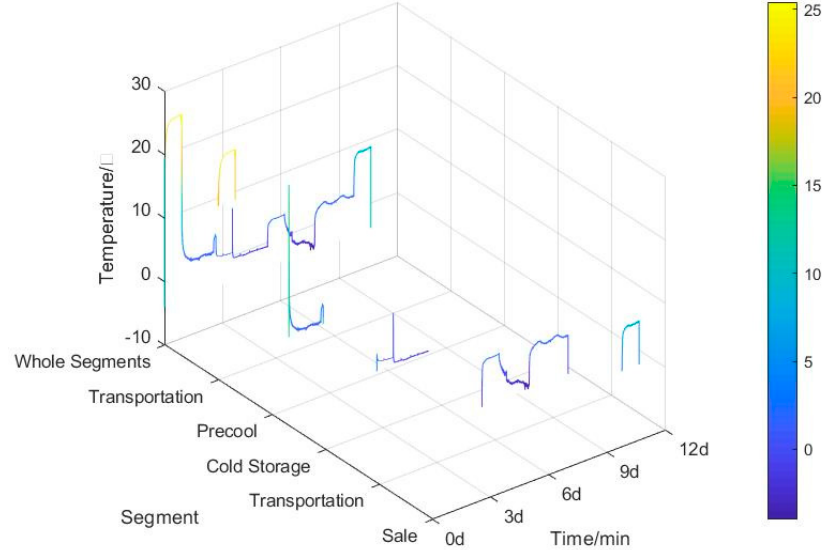
Figure 4. The change of temperature in the fragrant pear cold chain.